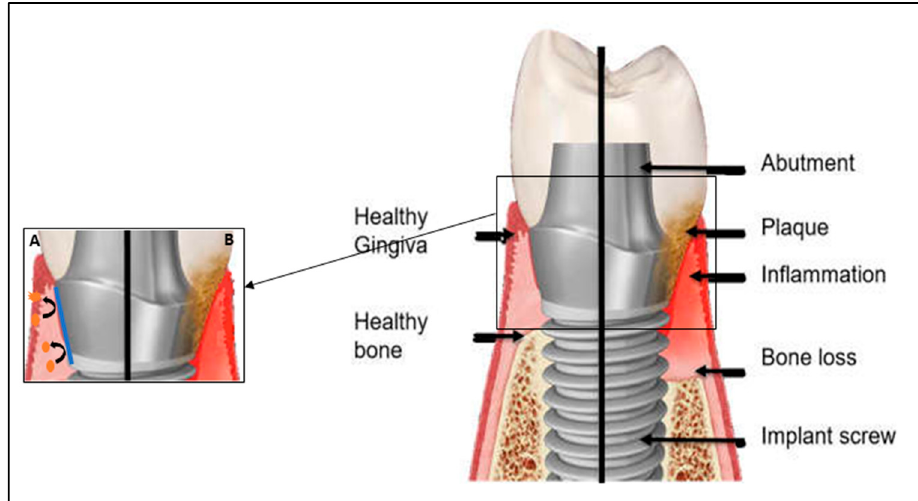
Figure 1. Biofilm formation process around dental implants and dental structures. ( A ) Implant coating prevents microbial colonization. ( B ) Dental plaque formation.